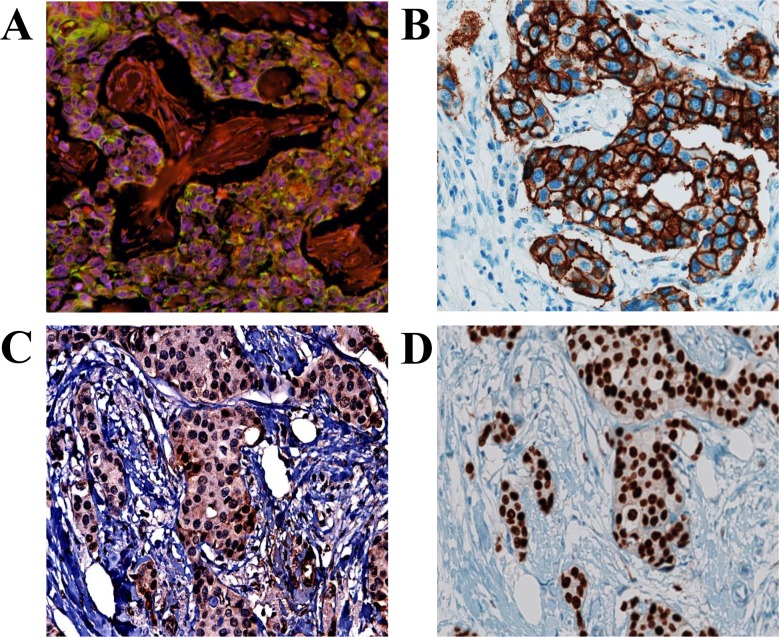
Association between BRCA1 and other prognostic markers.A: Positive BRCA1 staining in an invasive ductal carcinoma core. B, C, and D: Positive Her2, CK5/6 and AR staining in corresponding sections of the same core.